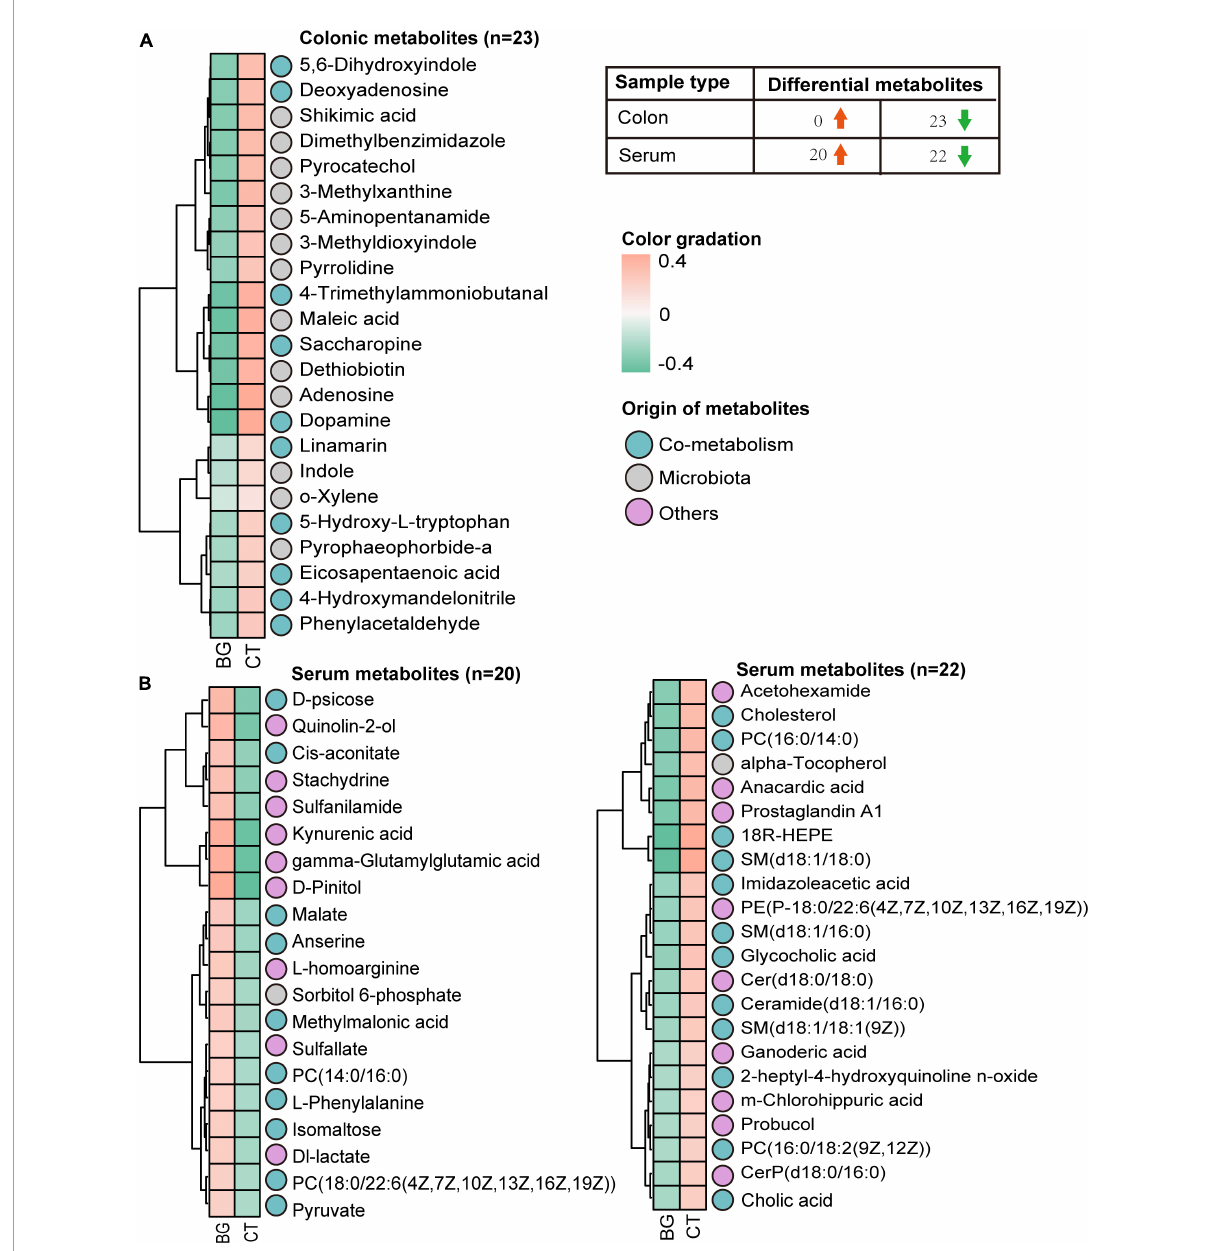
FIGURE3 The heatmap. (A) Heatmap visualization of the colonic metabolites that differed between the oat β -glucan (BG) and control (CT) groups. (B) Heatmap visualization of the serum metabolites that differed between the oat BG and CT groups.